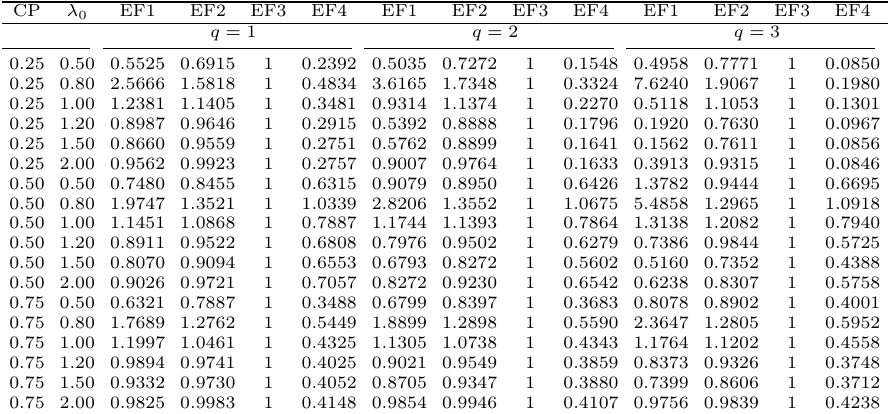
Relative efficiencies of the estimators of (cid:21) q (when (cid:21) = 0 : 8 ) under Type II censoring CP